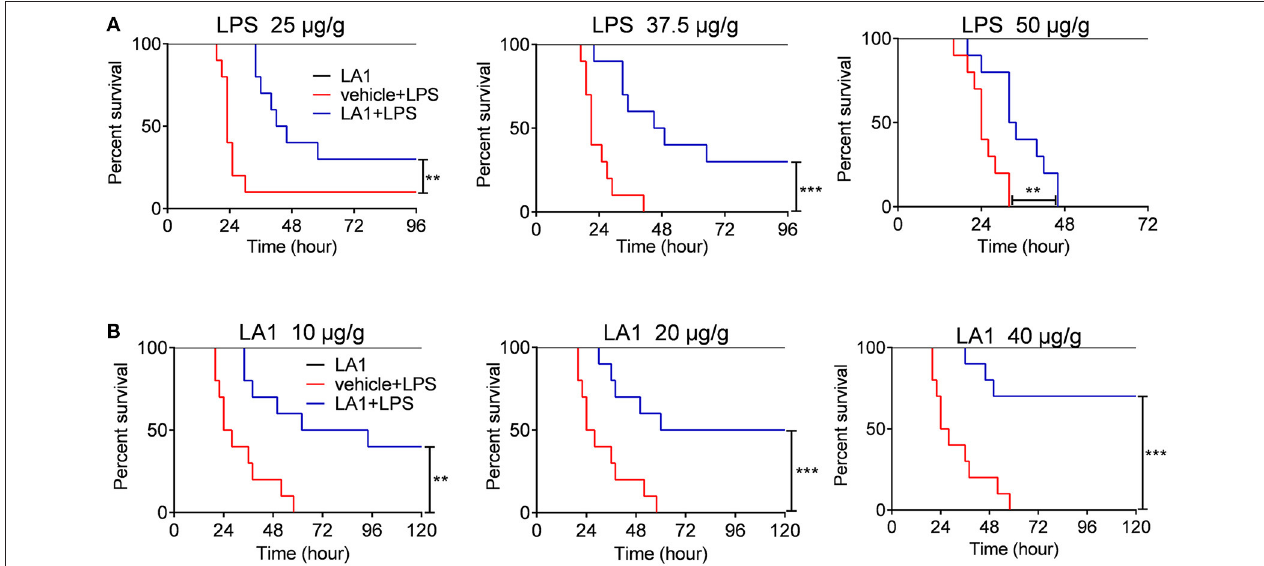
FIGURE 1 | Activation of CD11b by LA1 reduced LPS-induced mortality. (A) C57BL/6 mice were treated with either LA1 (40 µ g/g of body weight) or vehicle followed by LPS stimulation (25, 37.5, and 50 µ g/g of body weight). The survivals of mice were observed ( n = 10 mice/group) ** P < 0.01, *** P < 0.001. Kaplan–Meier method was used to estimate overall survivals and the survival rates were determined by Log-rank test. (B) C57BL/6 mice were treated with either LA1 (10, 20, and 40 µ g/g of body weight) or vehicle followed by LPS (37.5 µ g/g of body weight) stimulation. The survivals of mice were observed ( n = 10 mice/group) ** P < 0.01, *** P < 0.001. Kaplan–Meier method was used to estimate overall survivals and the survival rates were determined by Log-rank